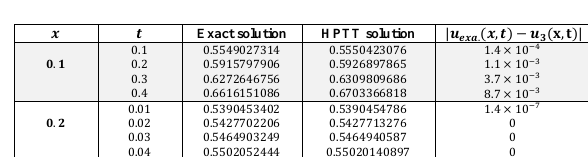
Table 1: Absolute errors for differences between the exact solution and 3 rd order HPTT solution for diverse values x and t when ρ = −1, β = 1 , for Ex. 5.1